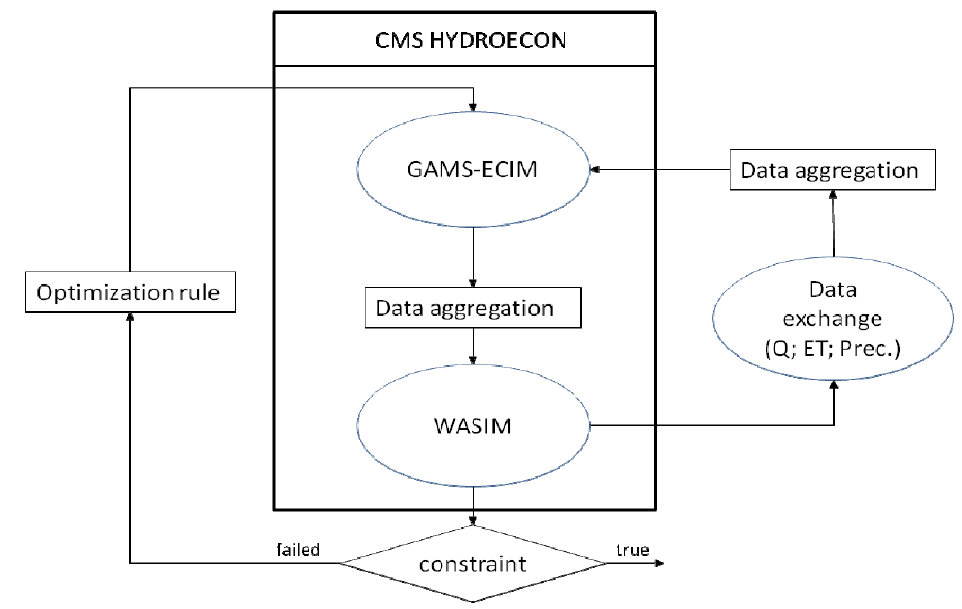
Figure 4. The structure and main information flows of the GLOWA-Volta model system (adapted from